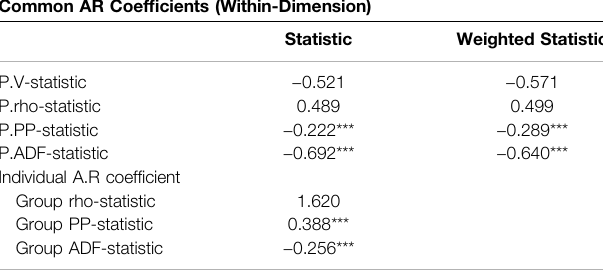
TABLE 2 | Test for cross sectional